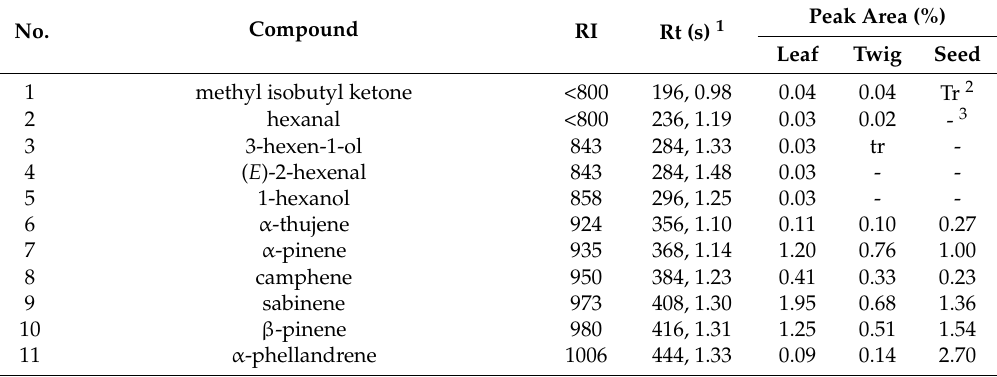
Table 1. Chemical compounds identified in the essential oils from C. camphora by two-dimensional